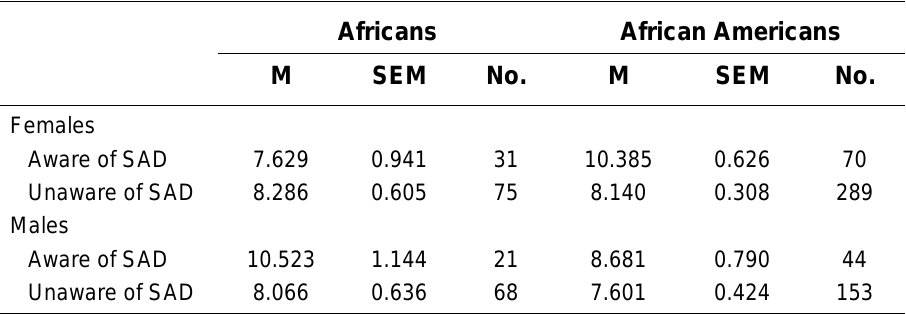
GSS by Ethnicity and Gender